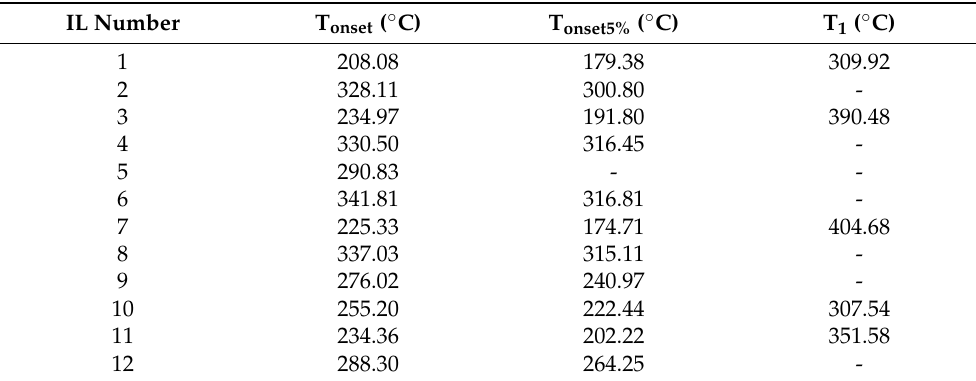
Table 3. Thermal decomposition temperatures obtained with TGA measurements for all ionic liquids presented in this